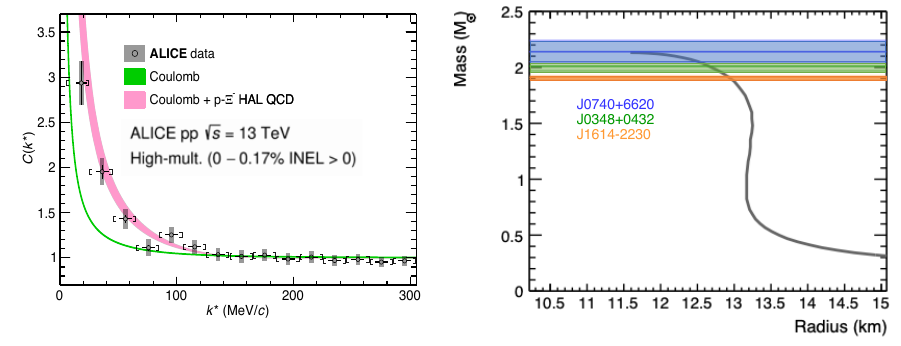
to reproduce the lattice constraint on U Ξ in medium is shown [11]. A maximum mass of